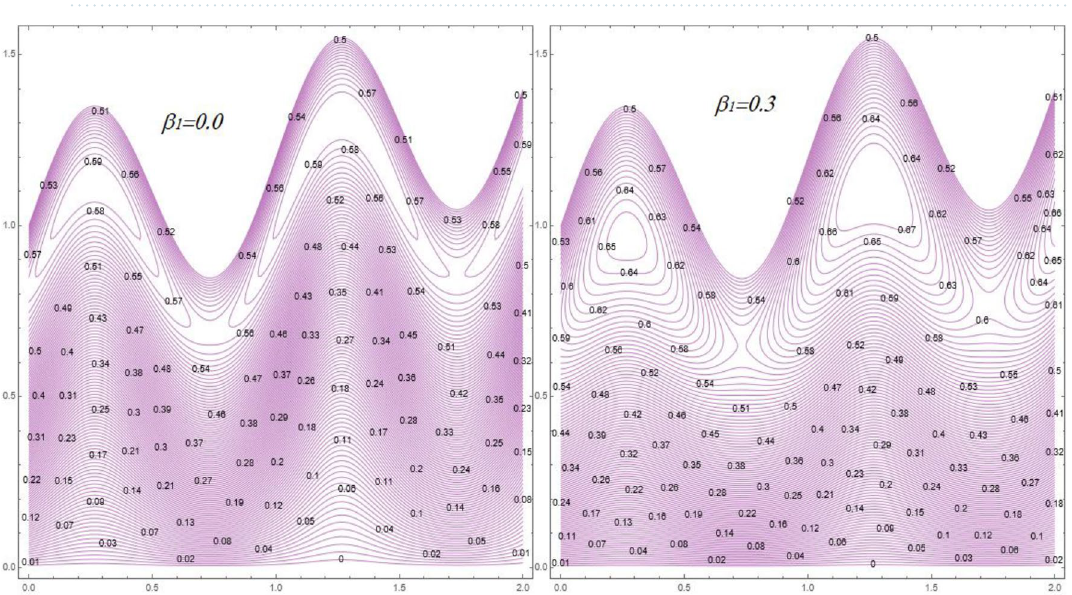
Figure 13. Streamlines behavior against different values of Prandtl fluid parameter (β 1 )